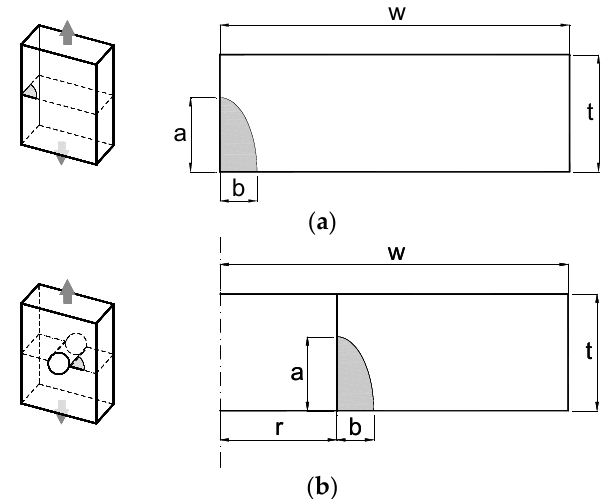
Figure 1. Crack emanating from: ( a ) the corner of a plate; ( b ) a hole.